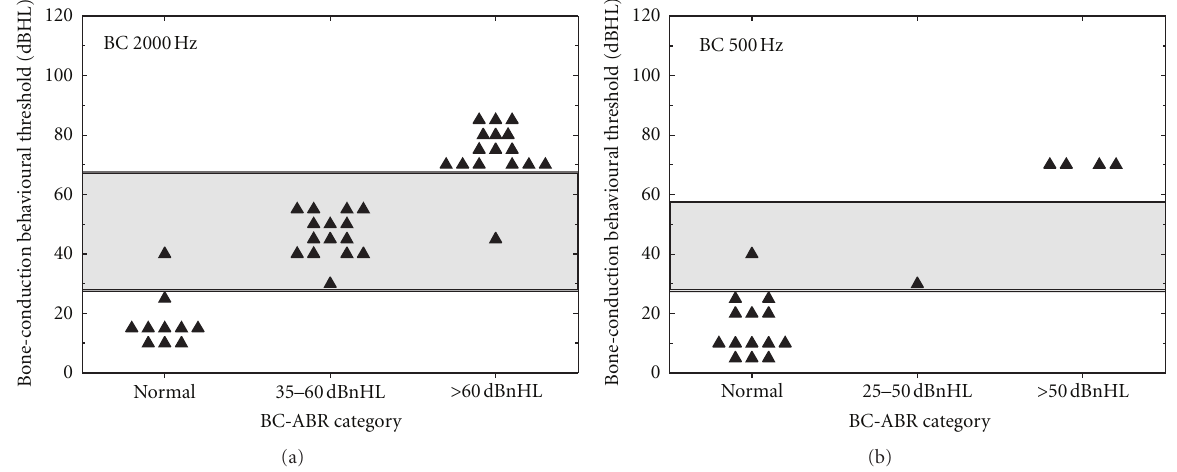
Figure 6: Comparison of BC-ABR threshold category to BC behavioural threshold data for 2000 Hz (a) and 500 Hz (b). Behavioural categories are indicated by horizontal